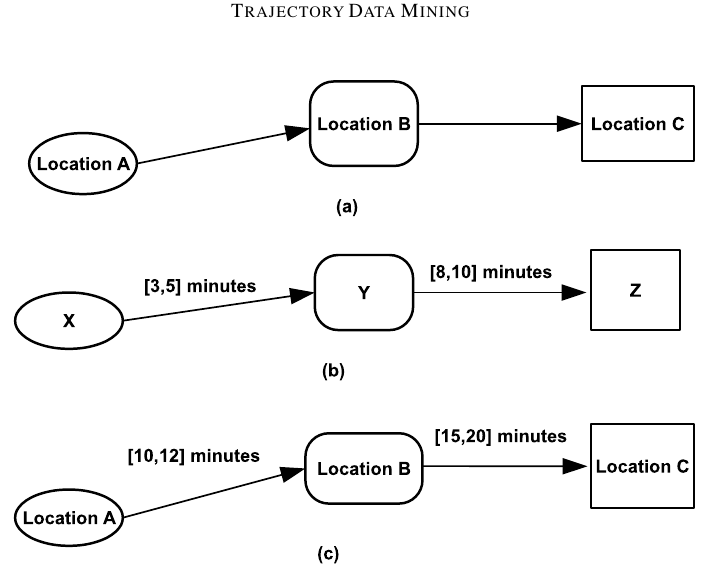
Figure 2: (a) A spatiotemporal sequential pattern, (b) a temporally annotated sequence (TAS), and (c) a